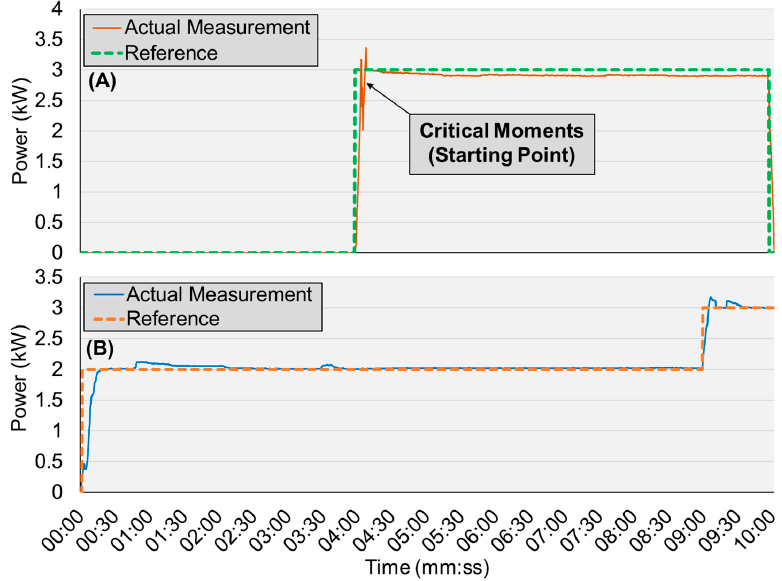
Figure 13. Emulated consumption profile of the system by the motor bench: ( A ) irrigation motors; ( B ) water pumping motor.